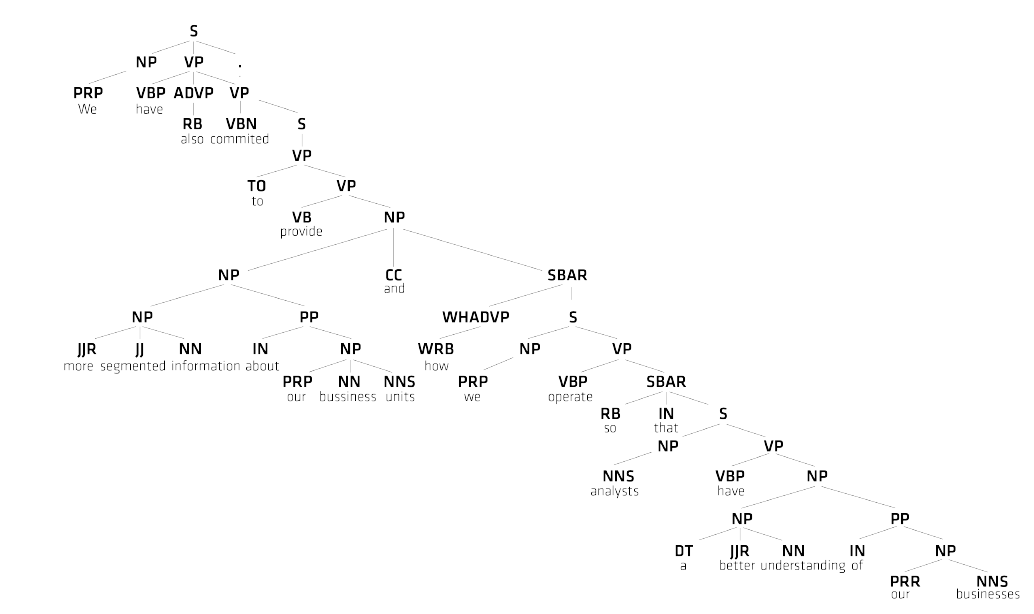
Figure 3. Phrase structure tree created by parsing of the example sentence within the Enron